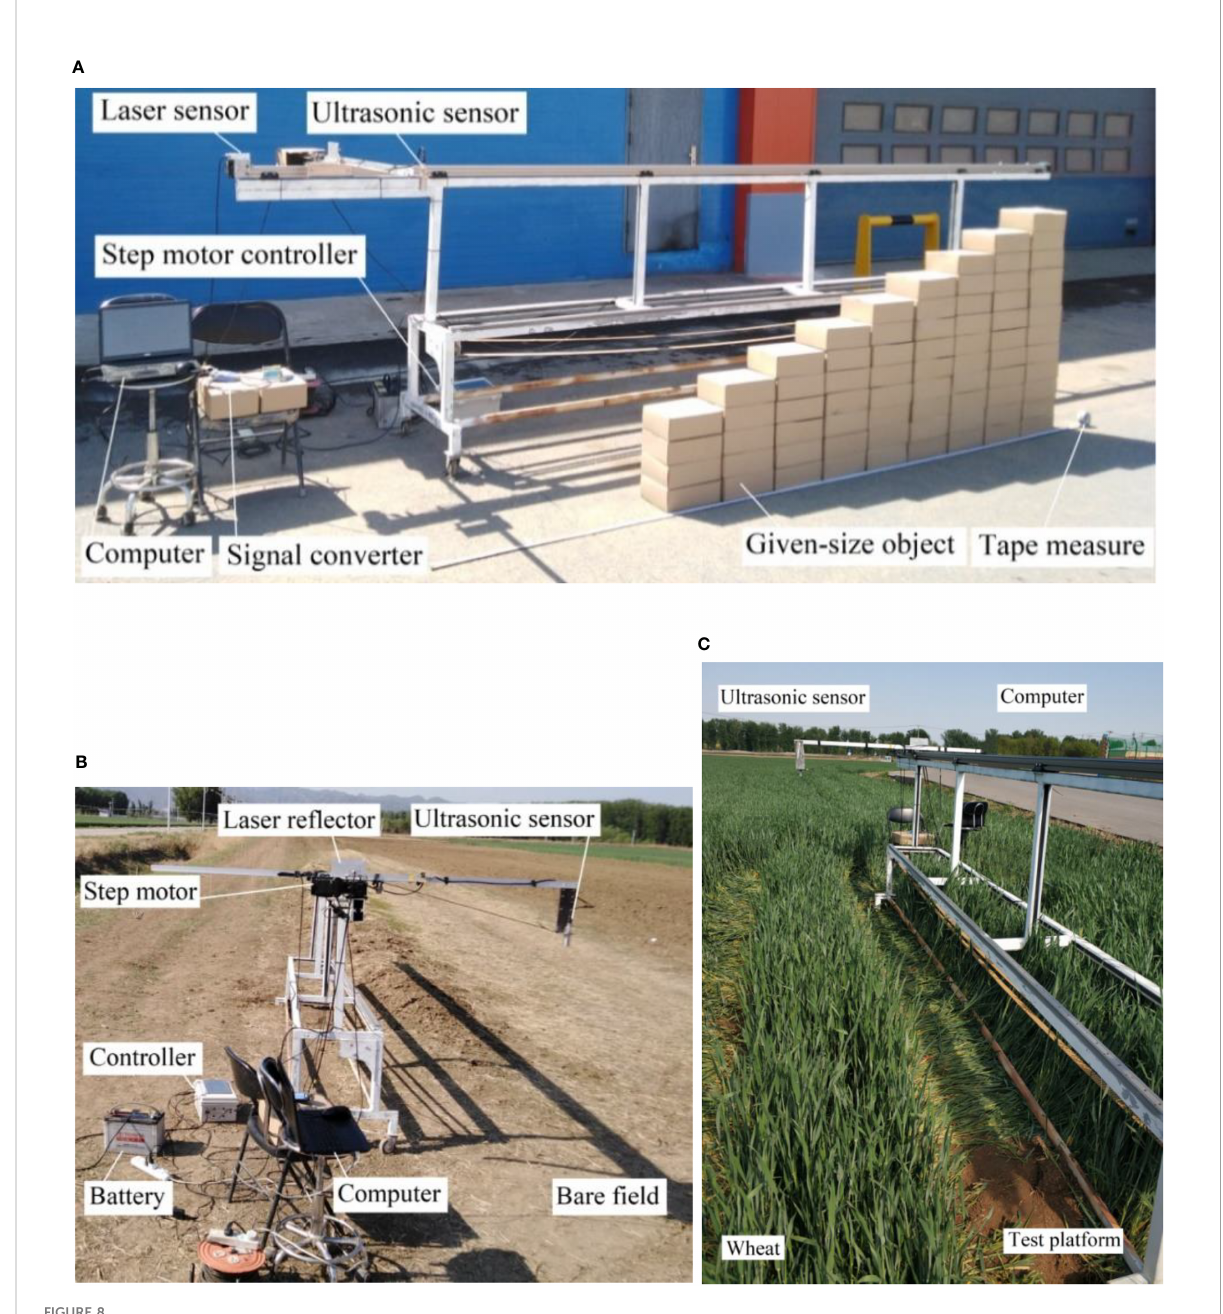
FIGURE 8 Regular step detection test by ultrasonic sensor. In order to fi nd out the in fl uencing factors and rules of real-time detection by ultrasonic sensors, experiments were conducted under three scenarios, namely, regular steps, bare soil and wheat canopy. (A) Regular step detection test by ultrasonic sensor; (B) Field ground detection test by ultrasonic sensor; (C) Wheat canopy detection test by ultrasonic